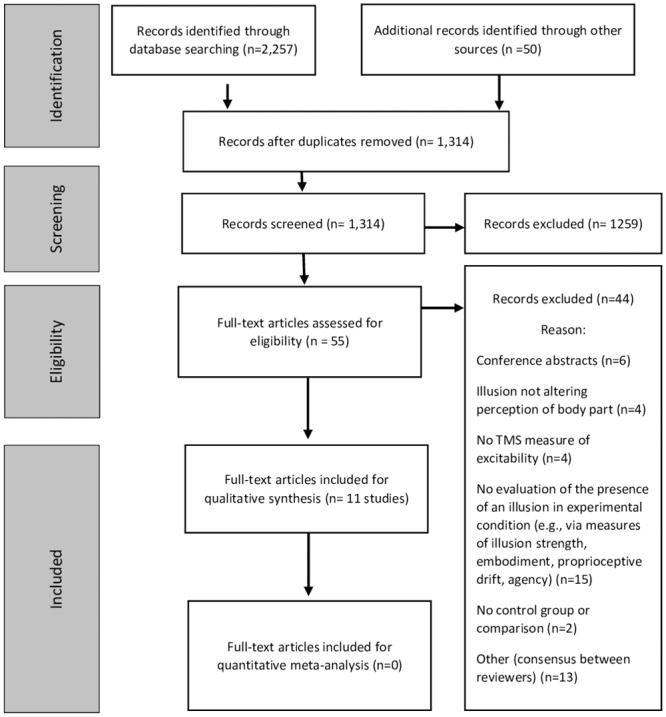
Flow diagram of the identification, screening and inclusion process.